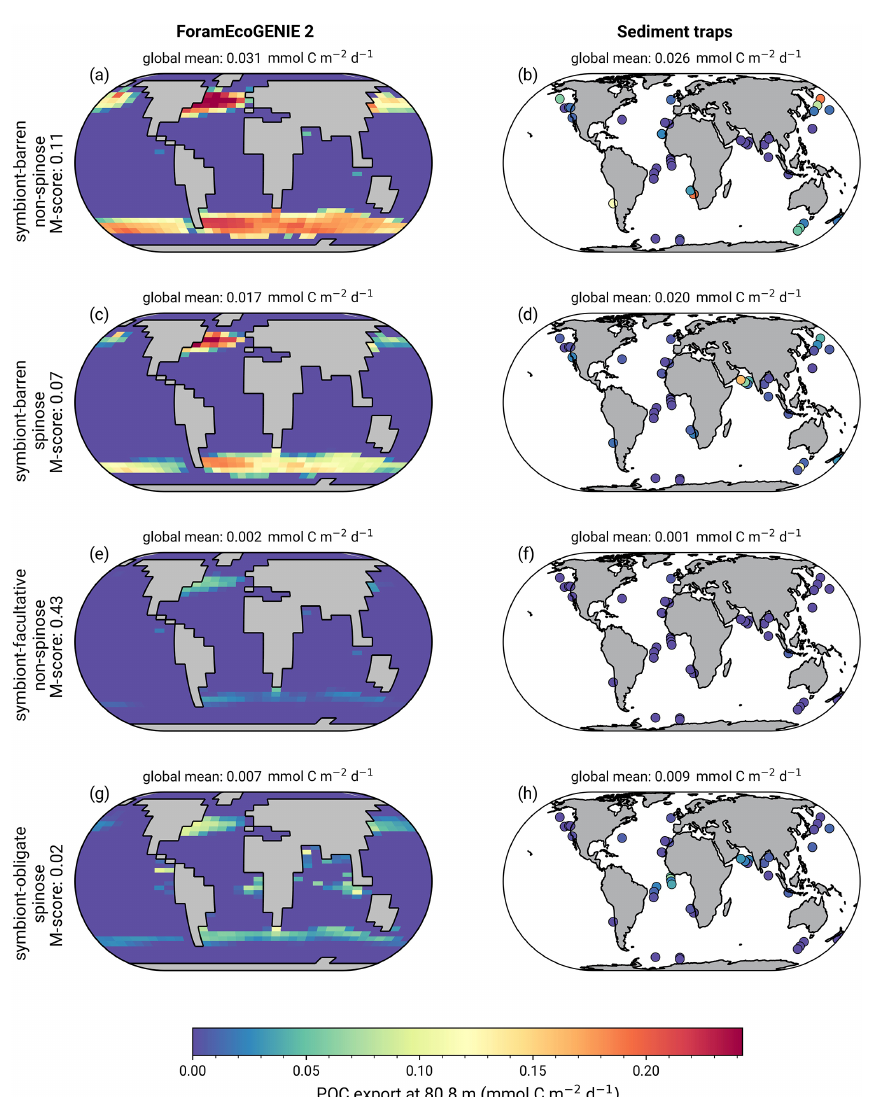
Figure 6. (a, c, e, g) ForamEcoGEnIE 2.0 foraminiferal annual average POC export (mmolCm − 2 d − 1 ) below the euphotic zone (80.8m) in comparison to sediment trap samples (b, d, f, h)